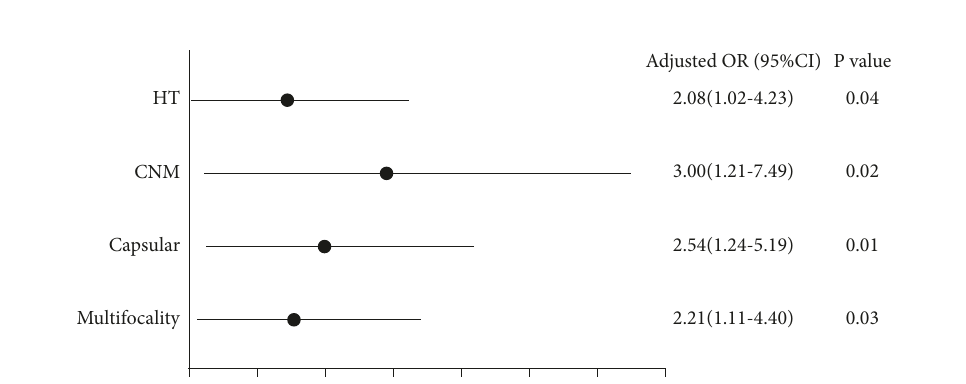
Figure 2: Forest plot of the significant factors in multivariate logistic regression of predicting contralateral occult papillary thyroid